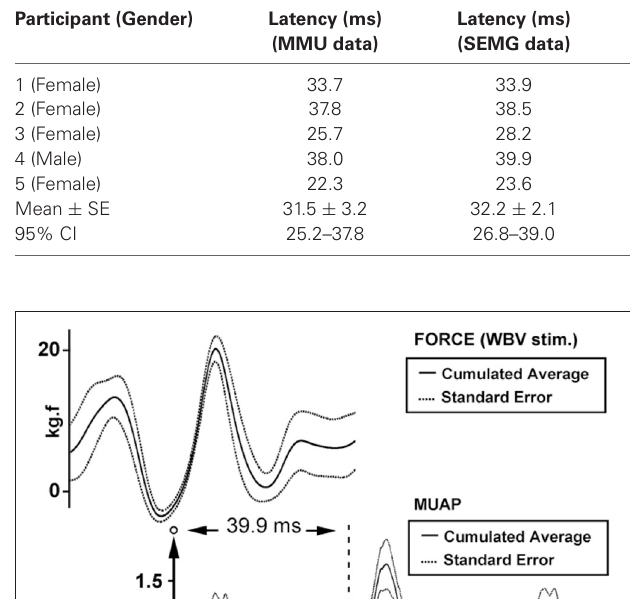
Table 1 | The reflex response latency calculated with the cumulated average method .